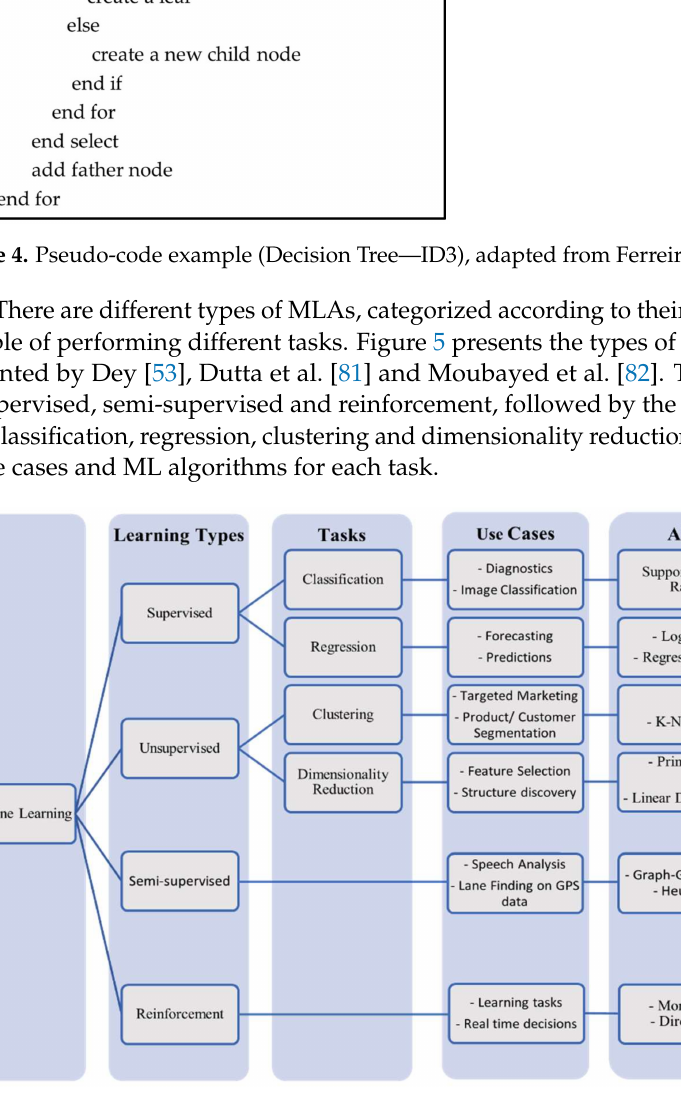
Figure 5. MLA learning types, use cases and algorithms, adapted from Dutta et al. [81], Kim & Tagkopoulos [83], Kumar et al. [84] and Moubayed et al.